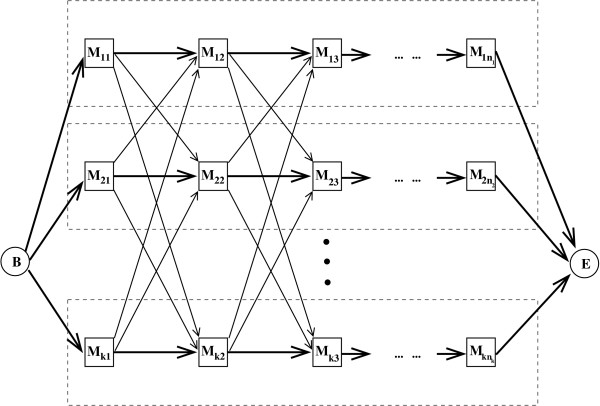
Simplified topology of a jumping profile HMM (jpHMM). The sequence family S
 MathType@MTEF@5@5@+=feaafiart1ev1aaatCvAUfKttLearuWrP9MDH5MBPbIqV92AaeXatLxBI9gBamrtHrhAL1wy0L2yHvtyaeHbnfgDOvwBHrxAJfwnaebbnrfifHhDYfgasaacH8akY=wiFfYdH8Gipec8Eeeu0xXdbba9frFj0=OqFfea0dXdd9vqai=hGuQ8kuc9pgc9s8qqaq=dirpe0xb9q8qiLsFr0=vr0=vr0dc8meaabaqaciaacaGaaeqabaWaaeGaeaaakeaaimaacqWFse=uaaa@3845@ is partitioned into k subtypes S
 MathType@MTEF@5@5@+=feaafiart1ev1aaatCvAUfKttLearuWrP9MDH5MBPbIqV92AaeXatLxBI9gBamrtHrhAL1wy0L2yHvtyaeHbnfgDOvwBHrxAJfwnaebbnrfifHhDYfgasaacH8akY=wiFfYdH8Gipec8Eeeu0xXdbba9frFj0=OqFfea0dXdd9vqai=hGuQ8kuc9pgc9s8qqaq=dirpe0xb9q8qiLsFr0=vr0=vr0dc8meaabaqaciaacaGaaeqabaWaaeGaeaaakeaaimaacqWFse=uaaa@3845@1,...,S
 MathType@MTEF@5@5@+=feaafiart1ev1aaatCvAUfKttLearuWrP9MDH5MBPbIqV92AaeXatLxBI9gBamrtHrhAL1wy0L2yHvtyaeHbnfgDOvwBHrxAJfwnaebbnrfifHhDYfgasaacH8akY=wiFfYdH8Gipec8Eeeu0xXdbba9frFj0=OqFfea0dXdd9vqai=hGuQ8kuc9pgc9s8qqaq=dirpe0xb9q8qiLsFr0=vr0=vr0dc8meaabaqaciaacaGaaeqabaWaaeGaeaaakeaaimaacqWFse=uaaa@3845@k. Each subtype is modeled by a profile HMM here pictured as a dashed box. Arrows indicate possible transitions between states within the same subtypes and transitions between different subtypes, so-called jumps. For clarity we omit insert and delete states of the profile HMMs and sketch a case where the first three columns are consensus columns.